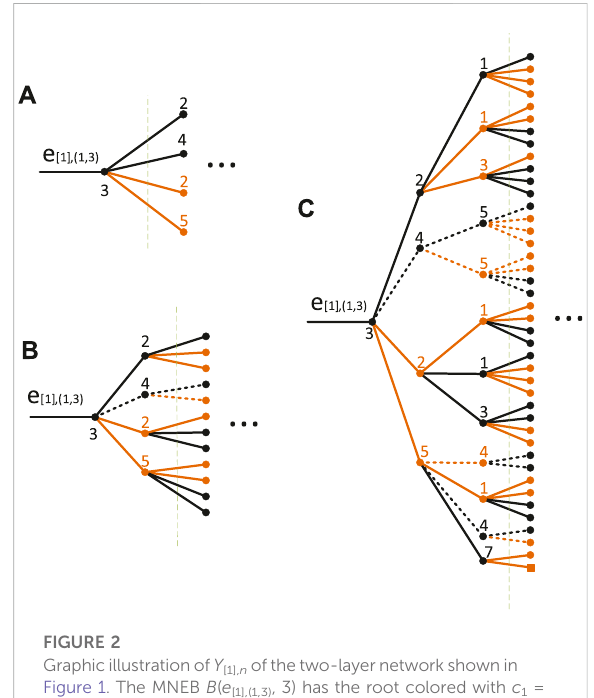
FIGURE 2 Graphicillustrationof Y [1], n ofthetwo-layernetworkshownin Figure 1. The MNEB B ( e [1],(1,3) , 3) has the root colored with c 1 = black . For example, we perform k = (1, 2)-core decomposition on the network. The green dashed line is the indication line of the fi rst n stratum of the MNEB. The solid lines in the MNEB represent the stubs that ful fi ll condition 2 under the given k . The condition that an MNEB belongs to Y [1], n is then decided by whether the MNEB has a solid sub-branch crossing the green dashed indication line. (A) shows that B ( e [1],(1,3) , 3) ∈ Y [1],1 . (B) shows that B ( e [1],(1,3) , 3) ∈ Y [1],2 . (C) shows that B ( e [1],(1,3) , 3) ∈ Y [1],3 . In addition, for k = (2, 2), we can also see that B ( e [1],(1,3) , 3) ∈ Y [1],1 (A) and B ( e [1],(1,3) ,3) ∈ Y [1],2 (B) .Butfor n =3,wecannot fi ndsuchasub- branchthatforeachblackvertexinthe fi rstthreestrataofthissub- branch, the number of red child vertices is no less than 2, and the number of black child vertices is no less than 1, and for each red vertexinthe fi rstthreestrataofthissub-branch,thenumberofred child vertices is no less than 1, and the number of black child vertices is no less than 2. Therefore, B ( e [1],(1,3) , 3) ∉ Y [1],3 . Here, the discs represent the vertices that have child vertices, and the squares represent the vertices without child